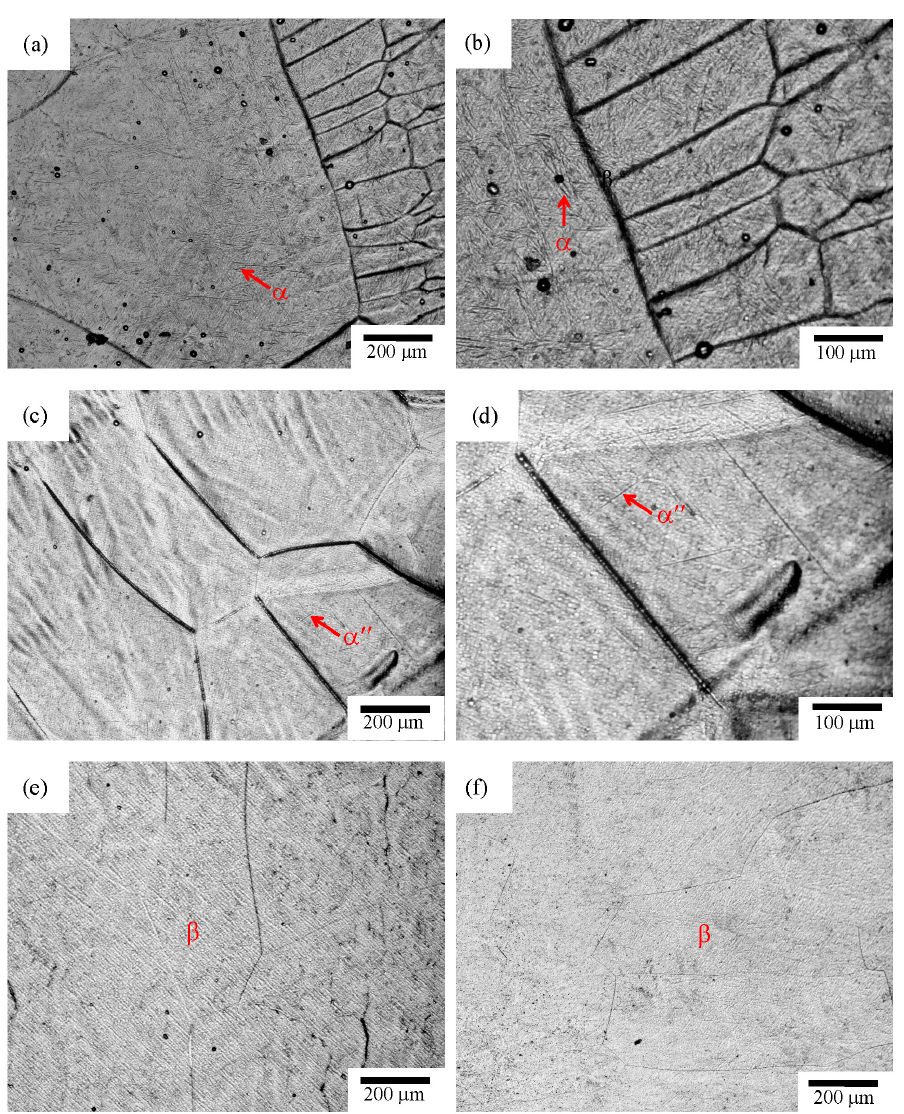
Figure 2. Microstructure of ( a ) and ( b ) Ti 85 Nb 10 Sn 5 , ( c ) and ( d ) Ti 82 Nb 13 Sn 5 , ( e ) Ti 79 Nb 16 Sn 5 , and ( f ) Ti 75 Nb 20 Sn 5 alloys observed by optics microscope.